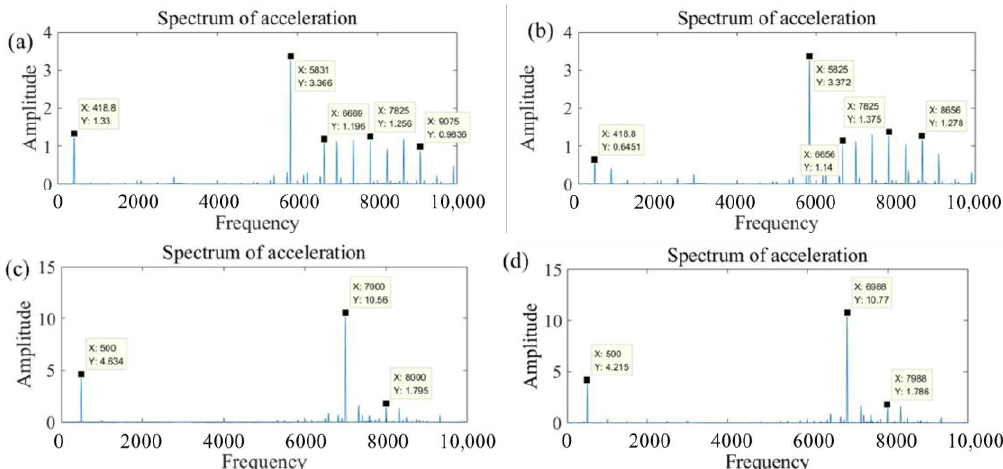
Figure 9. Vibration acceleration spectrum diagram with different conditions in frequency domain. ( a ) With a rotational speed of 25,000 rpm and no-load condition; ( b ) with a rotational speed of 25,000 rpm and conditions, ( c ) with a rotational speed of 30,000 rpm and no-load condition; ( d ) with a rotational speed of 30,000 rpm and conditions.